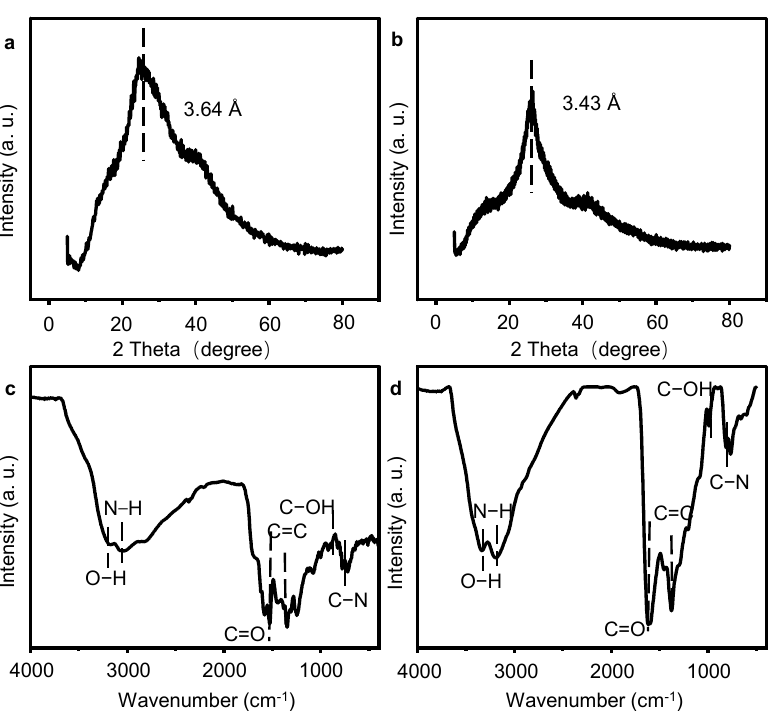
Figure 7. XRD spectra of GQDs ( a ) and N–GQDs ( b ). Infrared spectra of GQDs ( c ) and N–GQDs ( d ).